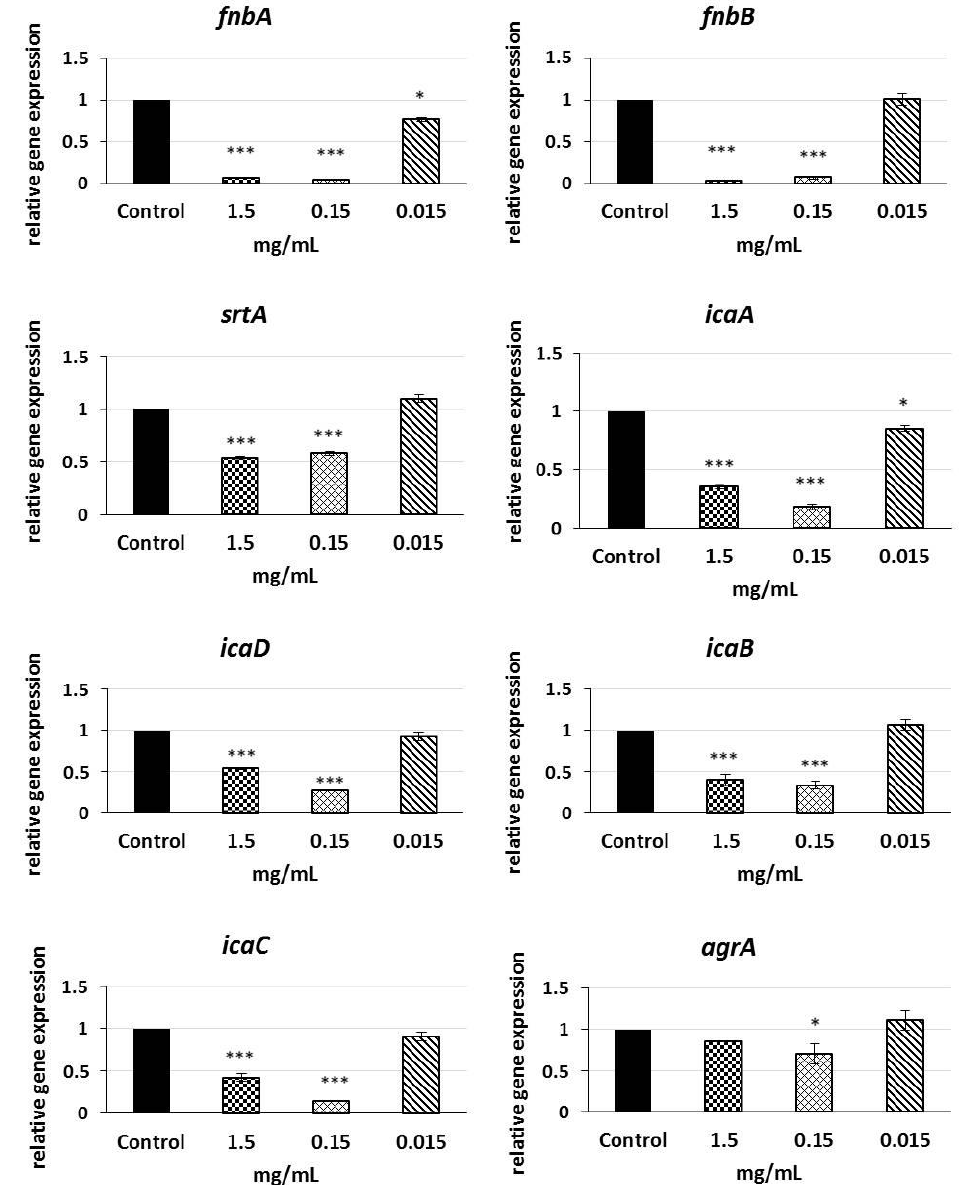
Figure 4. The effect of LPs 3/22 on mRNA (messenger RNA) decreased expression of biofilm-related genes in S. aureus CCM 4223; data are presented as means ± standard deviation; * ( p < 0.05) and *** ( p < 0.001)—significant difference compared to the non-treated control.